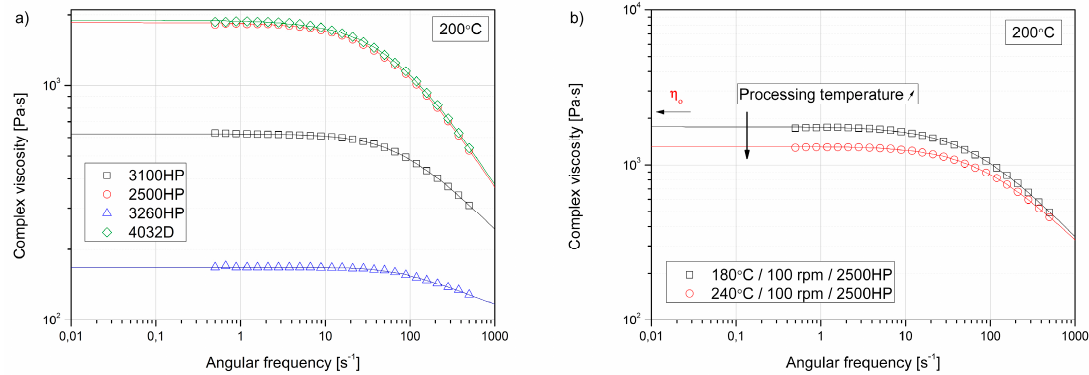
Figure 3. Complex viscosity curves of unprocessed PLA grades ( a ), and a comparison of the influence of processing temperatures on the complex viscosity curve of grade 2500HP ( b ).